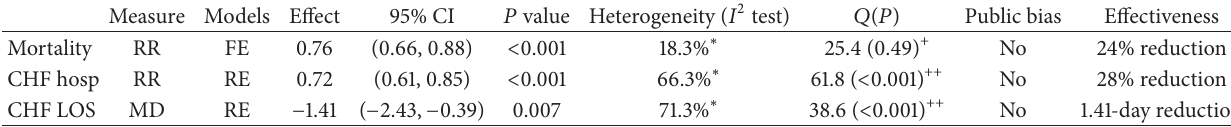
Table 2: Reduction effectiveness of different types of telehealth programs